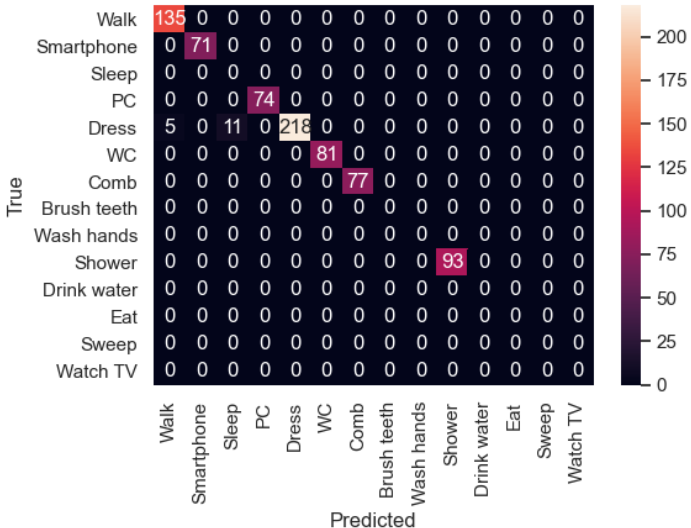
Figure 28. Sequence 3-Experiment 2-Confusion